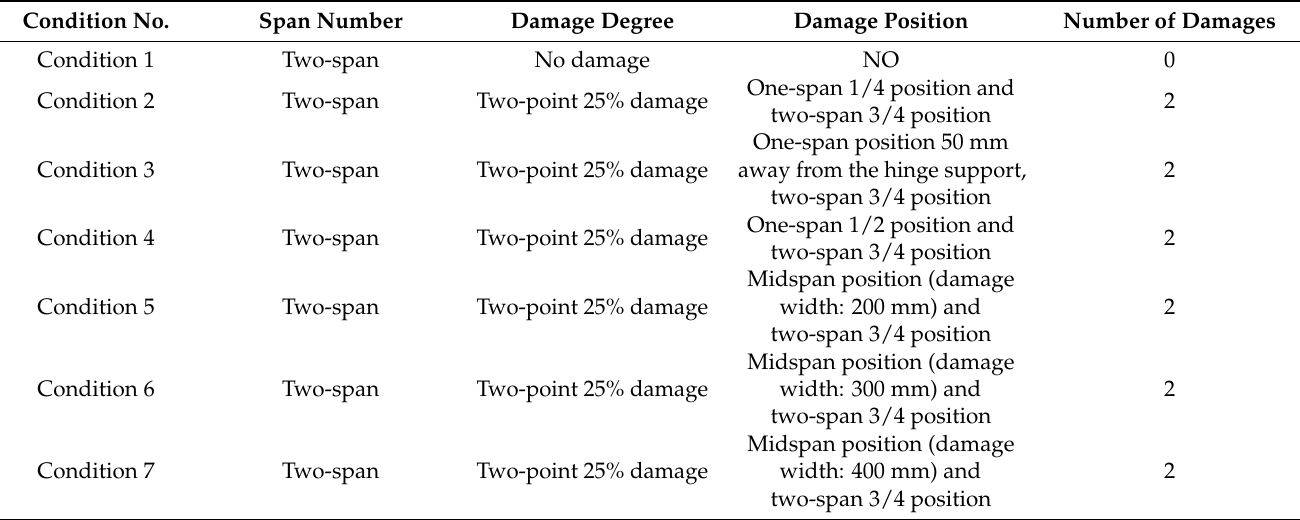
Table 7. Working conditions of the case.